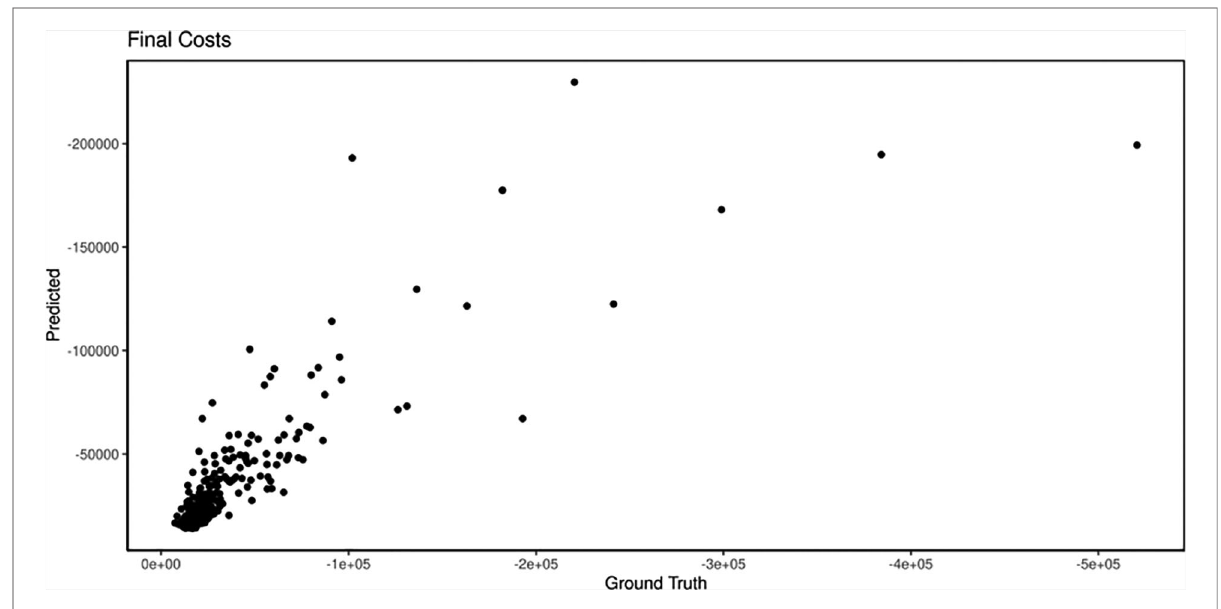
FIGURE 2 Predicted vs. real observations of the model (ground truth).